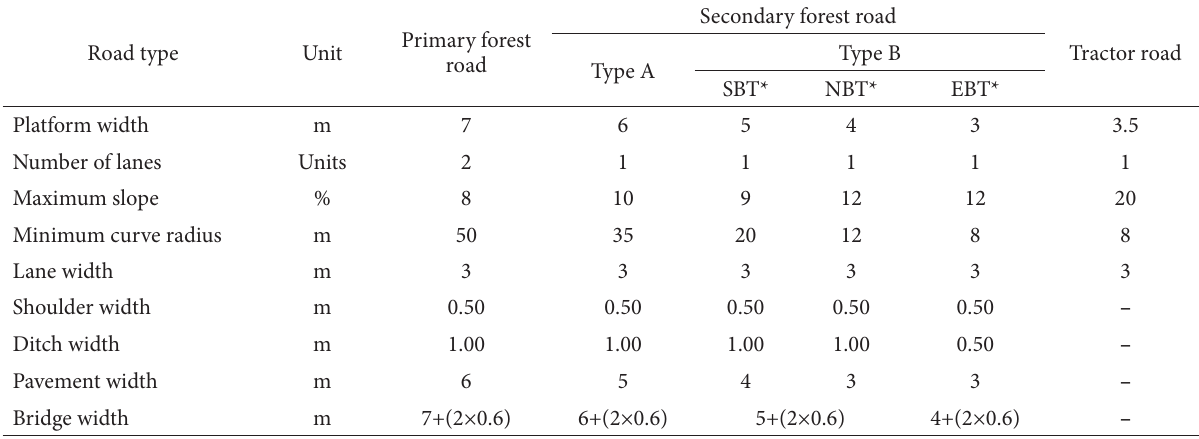
Table 1. Geometrical standards for forest roads (OGM 2008)